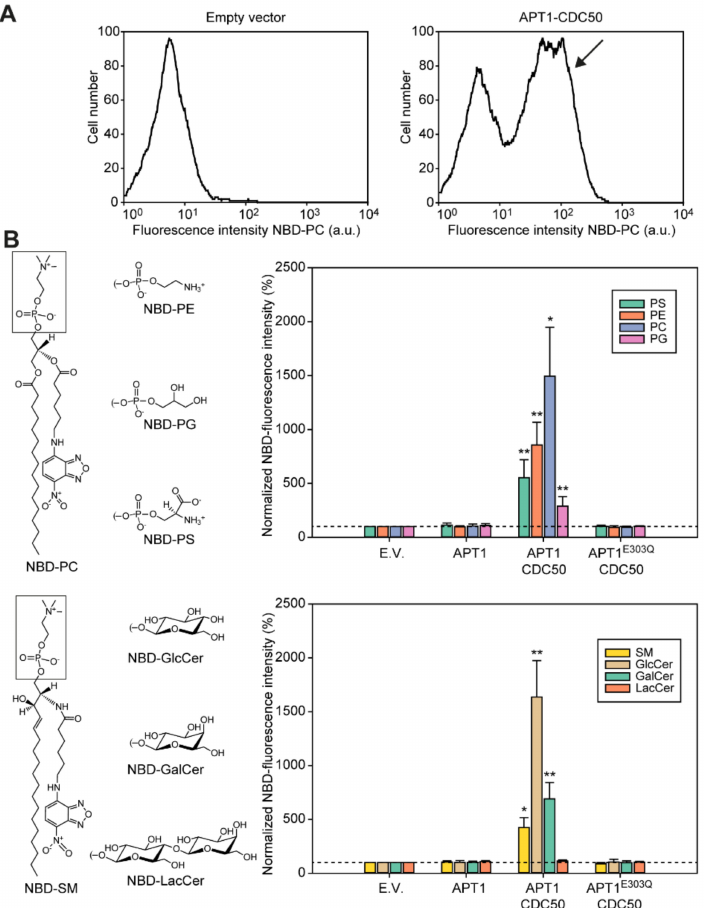
Figure 6. The Apt1p–Cdc50p P4-ATPase complex is a broad-specificity lipid flippase. Internalization of NBD-lipids by P4-ATPase-deficient (ZHY709) cells transformed with an empty vector or